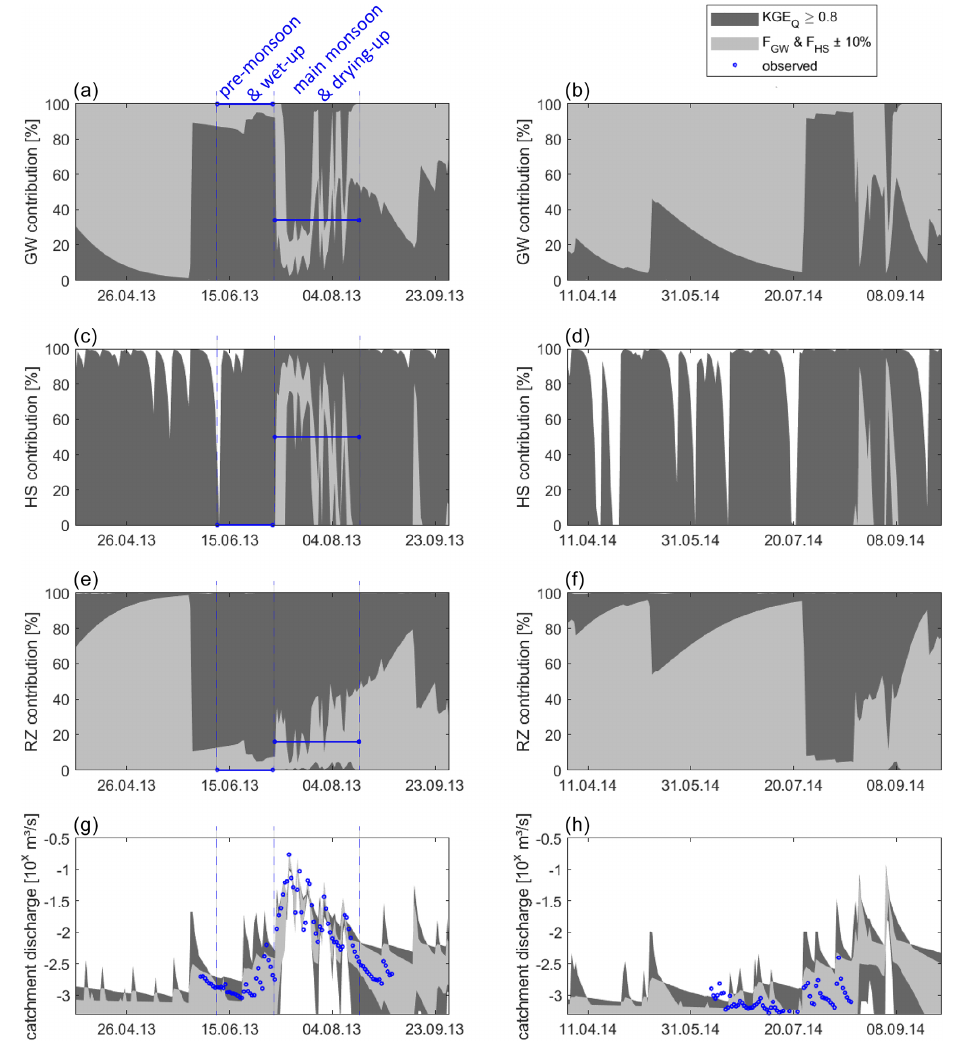
Figure 10. Simulated time series of contributions of groundwater (a,b) , subsurface storm flow (c,d) , riparian-zone discharge (e,f) , and total catchment discharge ( g,h ; blue points represent discharge observations from the test catchment, and blue lines indicate the experimentally derived contributions to streamflow, averaged over pre-monsoon and main monsoon; see Sect. 2.4) by using discharge (KGE Q ) only and by using F SSF and F GW during both years for parameter